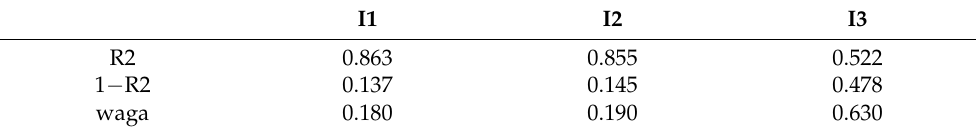
Table 4. Determination and indetermination coefficients used to construct synthetic indicator S2.